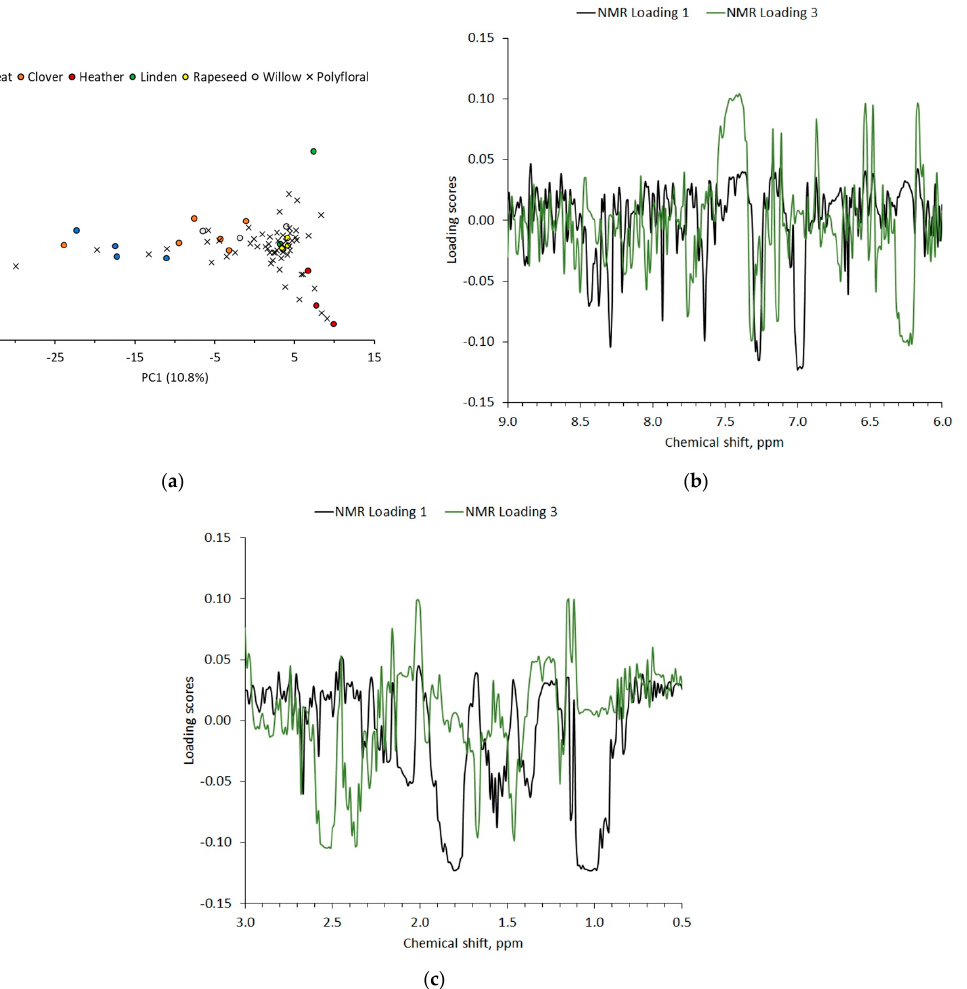
Figure 5. PCA of monofloral buckwheat, clover, heather, linden, rapeseed, willow, and polyfloral honey samples: ( a ) score plot between PC1 and PC3; loading plots of PC1 and PC3 for 1 H-NMR spectra with bin width 0.01 ppm for intervals ( b ) 9.0–6.0 ppm and ( c ) 3.0–0.5 ppm.